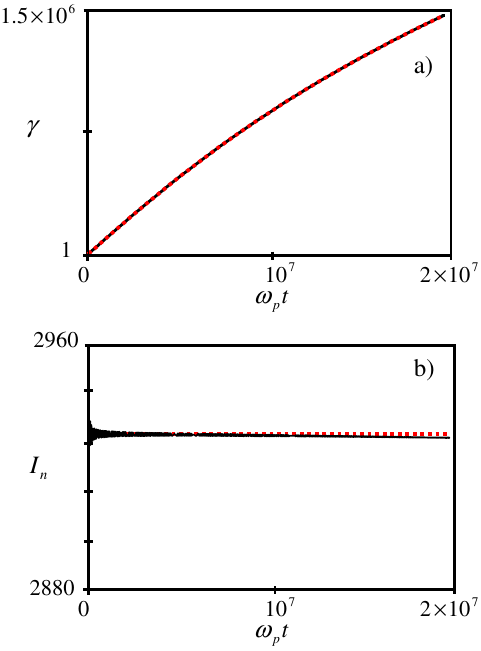
t calculated on ! n p